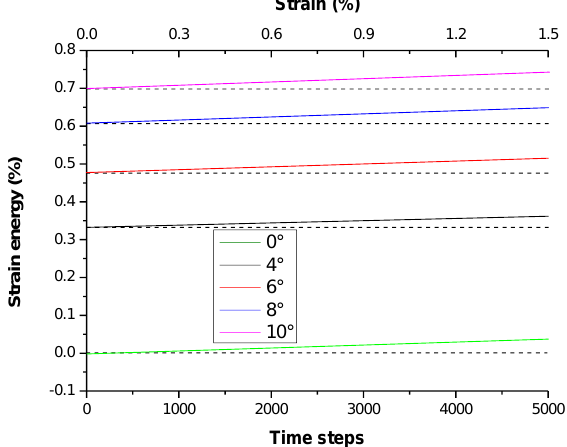
Figure 7. The increment percentage of the stored strain energy in deformed grain, which is calculated by using the PFC with the strain energy of single crystal as a reference point, changes with strain (%) or time steps for different misorientation θ of the GB.